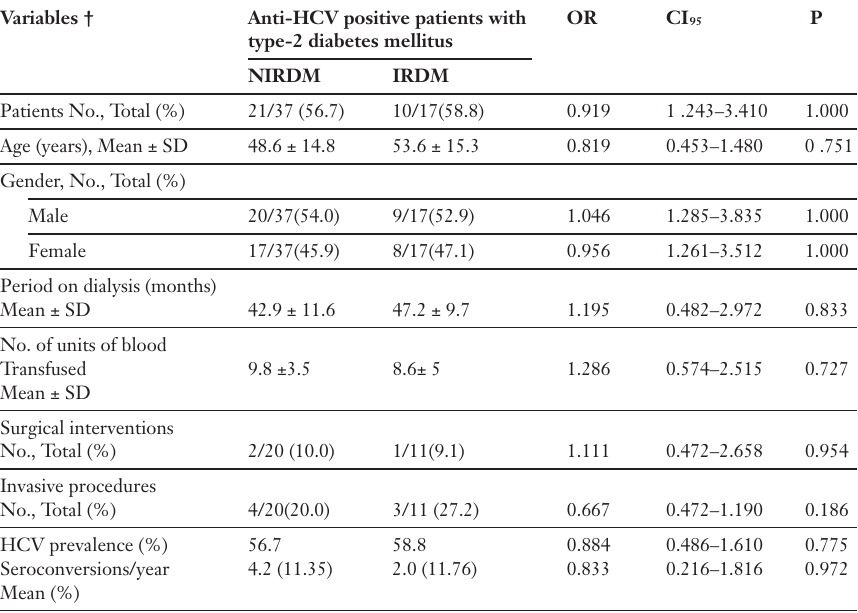
Determinants of HCV seroconversion between the two sub- groups of patients with type-2 diabetes mellitus -NIRDM (n = 37) and IRDM (n = 17) on haemo-